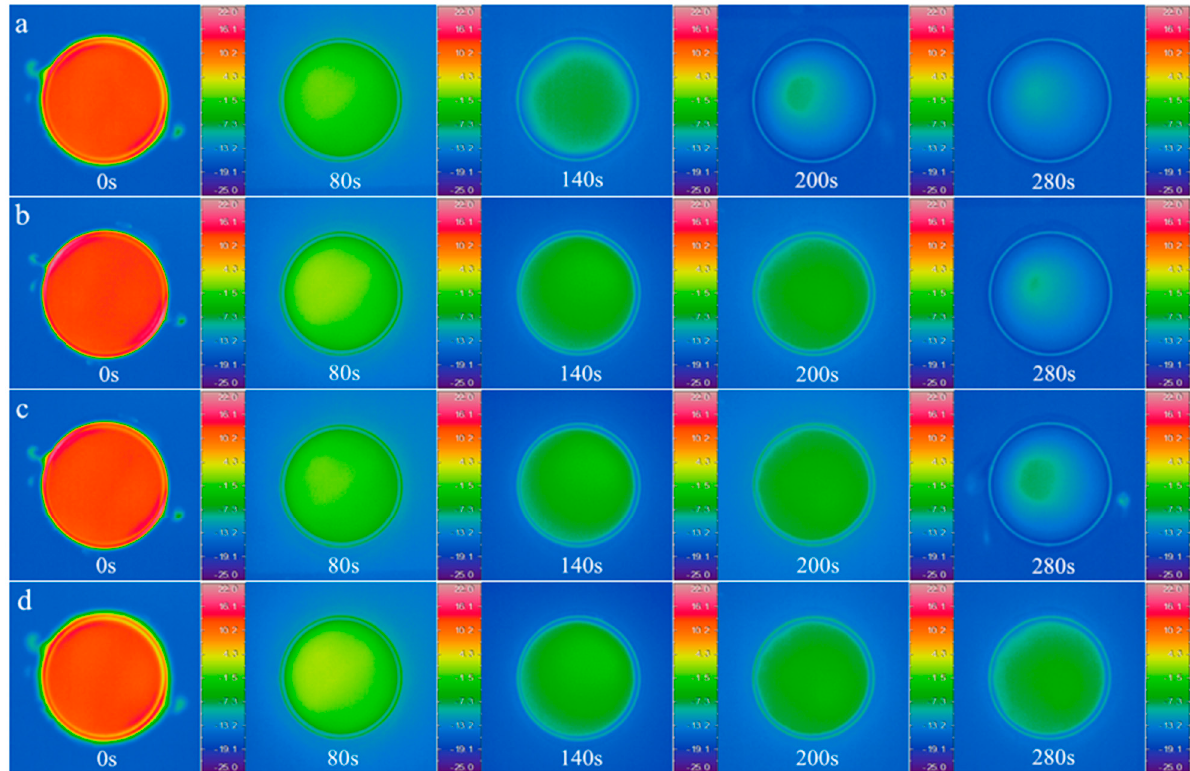
Figure 10. Infrared camera images of petri dishes with antifreeze fluid and different mass concentrations of MPCS under cooling process: ( a ) antifreeze fluid ( b ) 10 wt % ( c ) 20 wt % ( d ) 30 wt %.